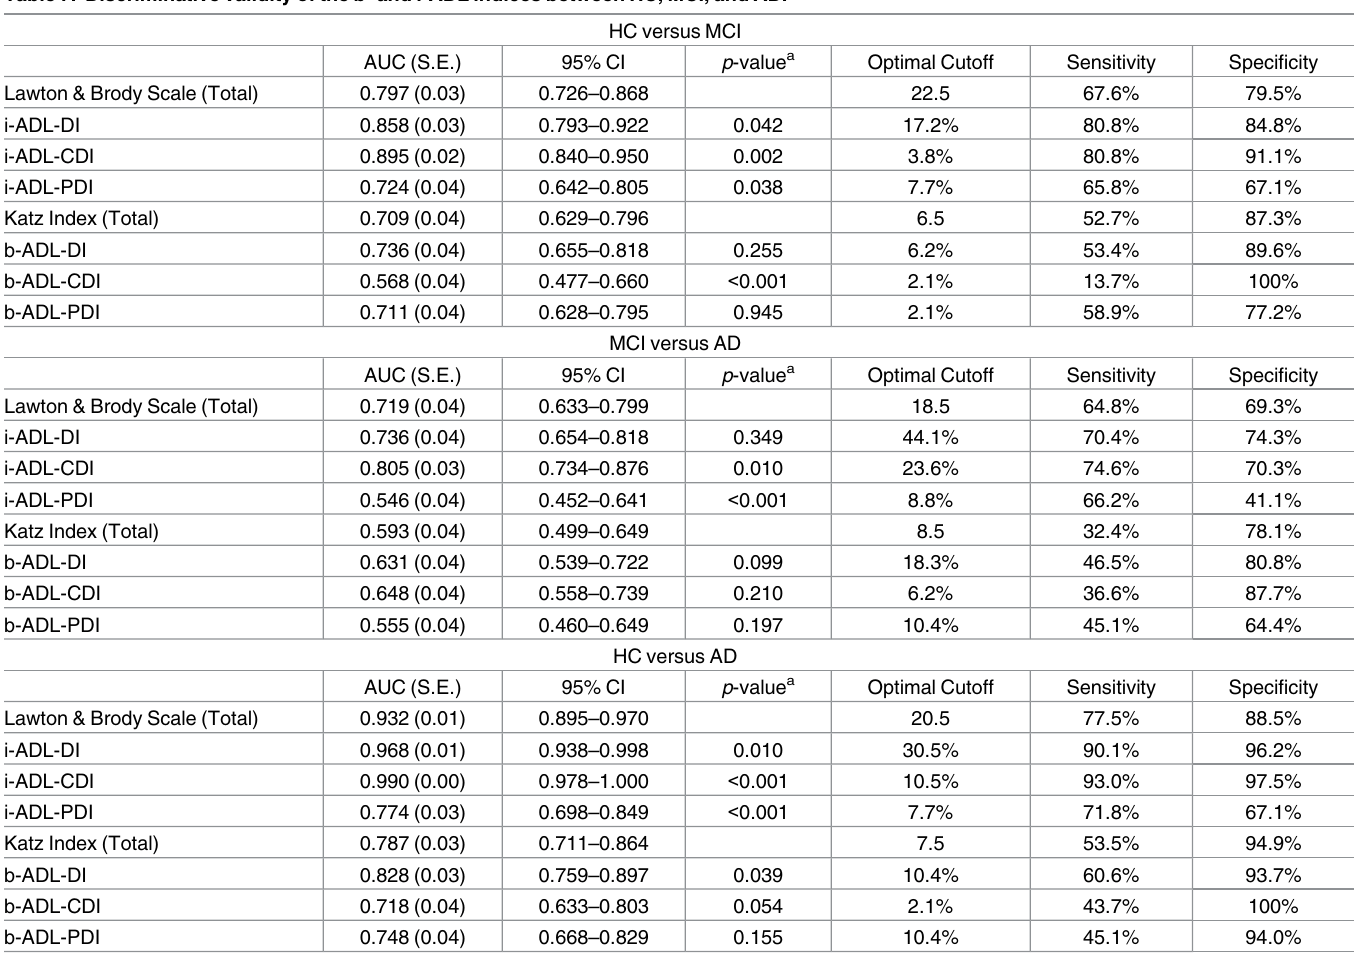
Table 7. Discriminative validity of the b- and i-ADL indices between HC, MCI, and